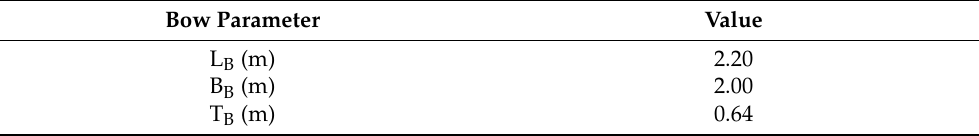
Table 3. Main particulars of the bow of the physical manned